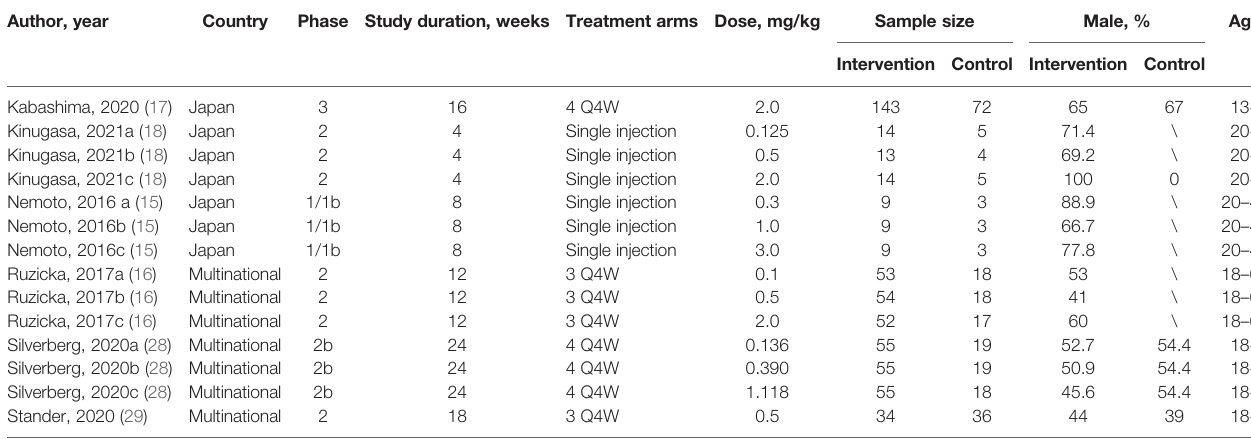
TABLE 1 | Characteristics of the included studies.